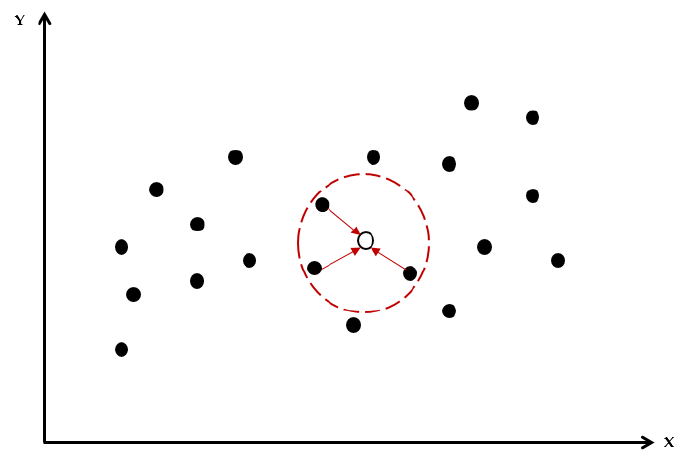
Figure 4. ( k = 3) K-nearest neighbor imputation.